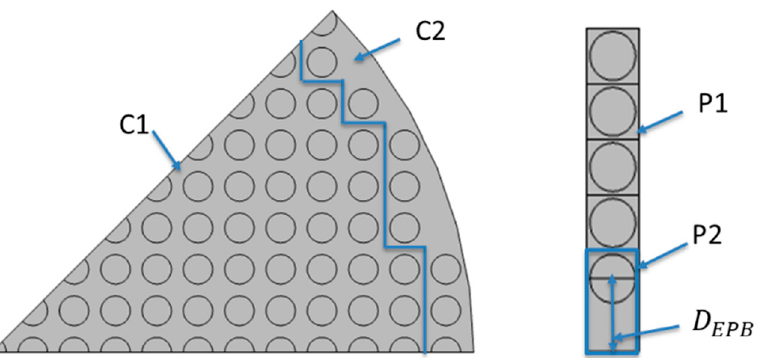
Figure 10. Illustration of the sections used in the EPB method for circular ( left ) and planar ( right ) bundles. Dashed lines divide the circular bundle into horizontal layers and the fiber closest to the wall in each layer is assigned to the wall section.